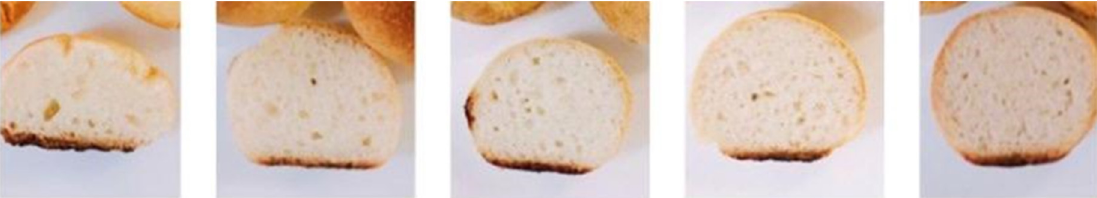
Figure 1. Gluten-free bread—from left to right, control gluten-free bread; bread with the addition of 12.5% of Amorphophallus konjac flour; 25%; 37.5%; and 50%.